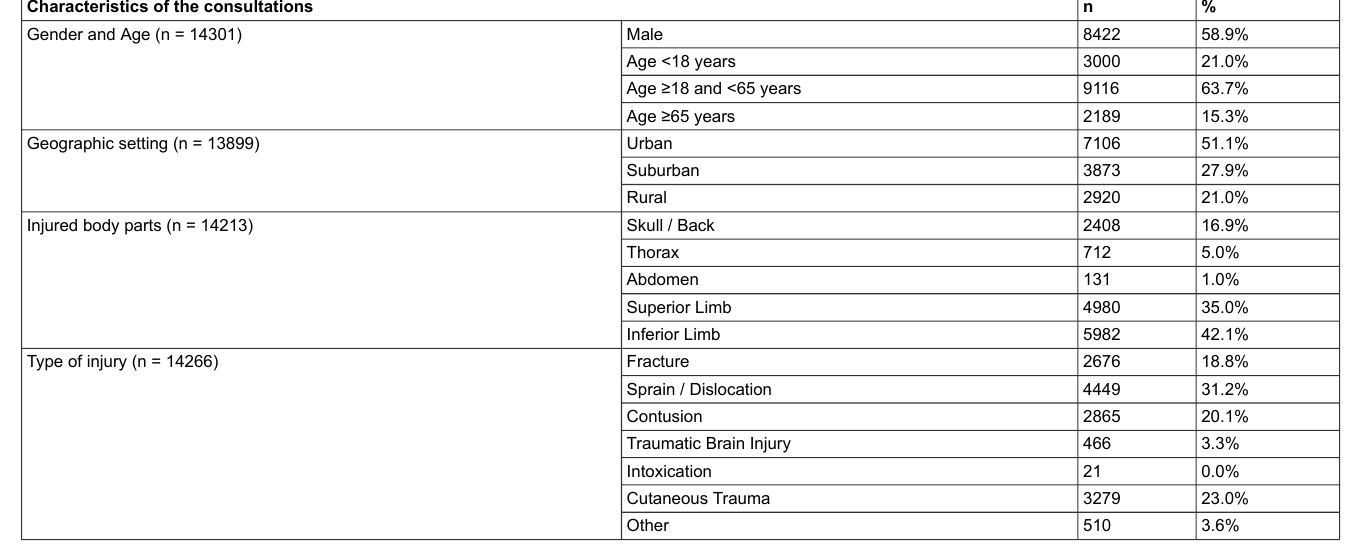
Table 2: Characteristics of injury-related consultations.* Characteristics of the